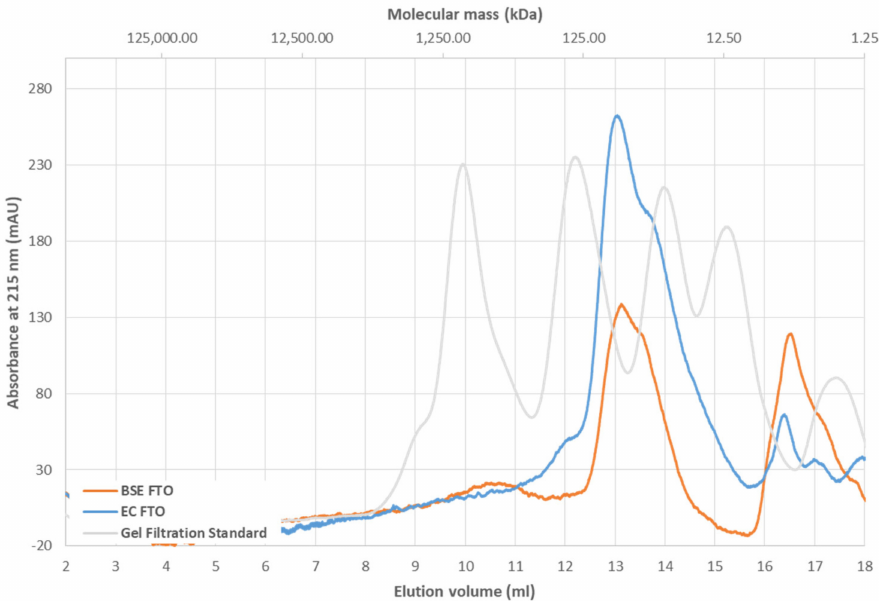
Figure 6. Gel filtration chromatography of EC FTO (blue) and BES FTO (orange) in the presence of 0.5 mM Mn 2+ and 1 mM 2-OG. Chromatograms show the presence of both versions of FTO in fractions corresponding to two state of the protein: the one clearly monomeric (peak around 50 kDa) and the second one (peak around 80 kDa) where the dynamic dimer/monomer equilibrium occurs.